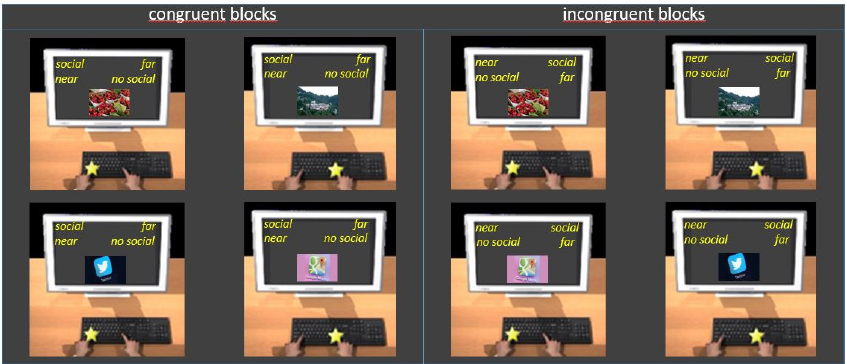
Figure 3. Examples of trials in congruent ( left panel ) and incongruent ( right panel ) blocks of Experiment 2. Participants had the instruction to press the E key with their left hand when the category to which the image belongs was written at the top left and to press the I key with their right hand when it was written at the top right (see the text for details).